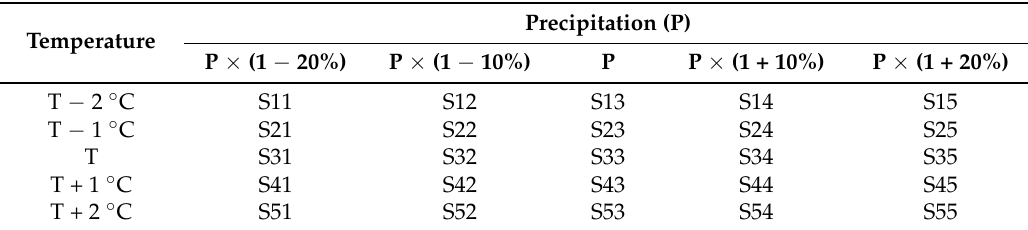
Table 1. Climate scenarios designed for the Lanhe Watershed.